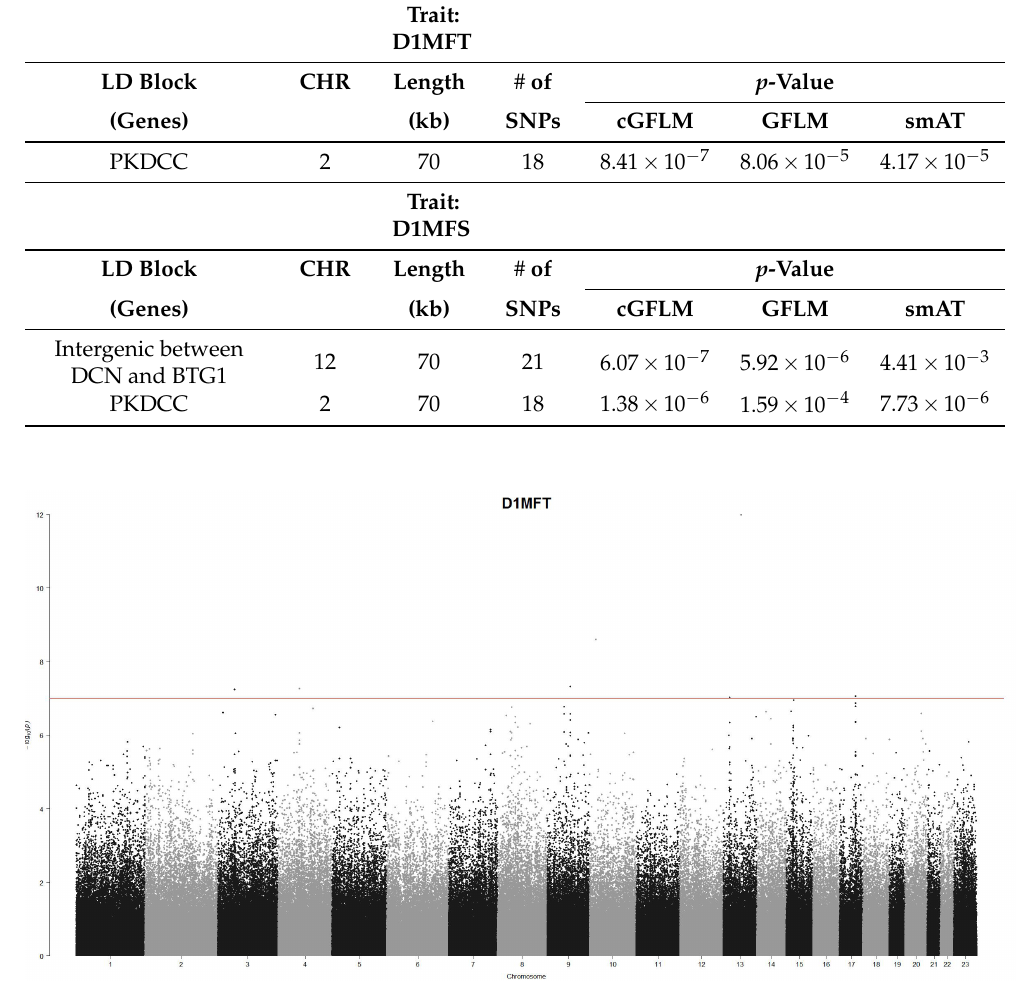
Figure 9. Genome-wide scanning for trait D1MFT using single-marker association tests based on the ZINB